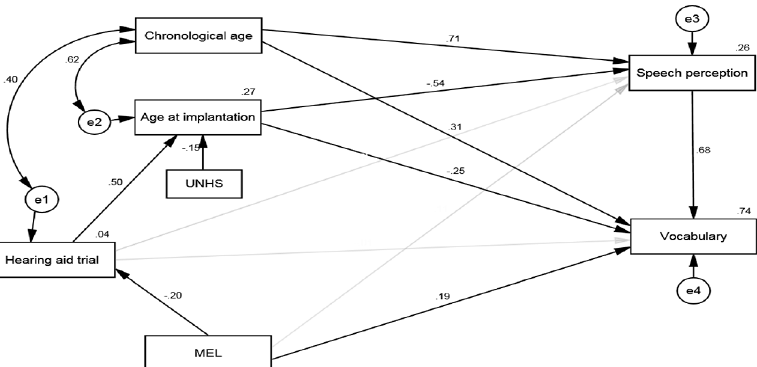
Fig 2. Final model describing the relationships among demographical variables, speech perception and vocabulary ability. Standardized path coefficients are presented at the midpoint of the unidirectional arrow paths (N = 115). Values noted besides the endogenous variables represent the percentage of variance accounted for each variable. The insignificant paths are shown in gray and their path coefficients are not presented. e represents the residuals in the prediction of endogenous factors from exogenous factors. Note: UNHS: universal newborn hearing screening, PTA: pre-implant hearing level, MEL: maternal education level.